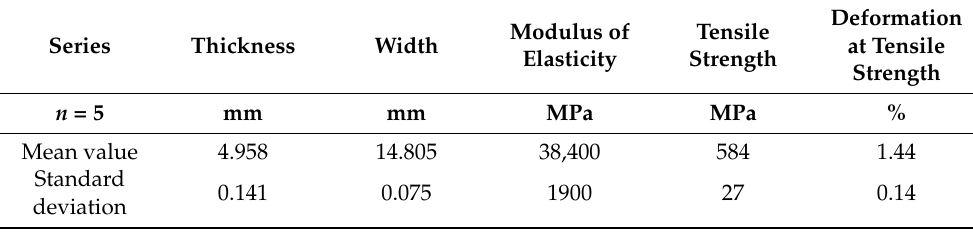
Table 2. Tensile testing results of resin with glass fibre cured PRO18-0264-01-00-01. Deformation Modulus of Tensile at Tensile Series Thickness Width Elasticity Strength Strength n = 5 mm mm MPa MPa % Mean value 4.958 14.805 38,400 584 1.44 Standard 0.141 0.075 1900 27 deviation